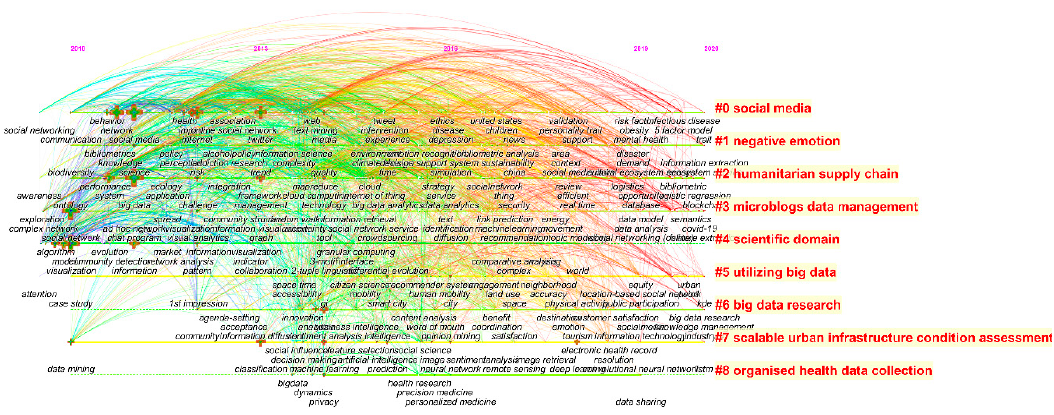
Figure 7. Knowledge map of keyword cluster in SMBD. Table 6. Frequency and centrality of keywords in SMBD.